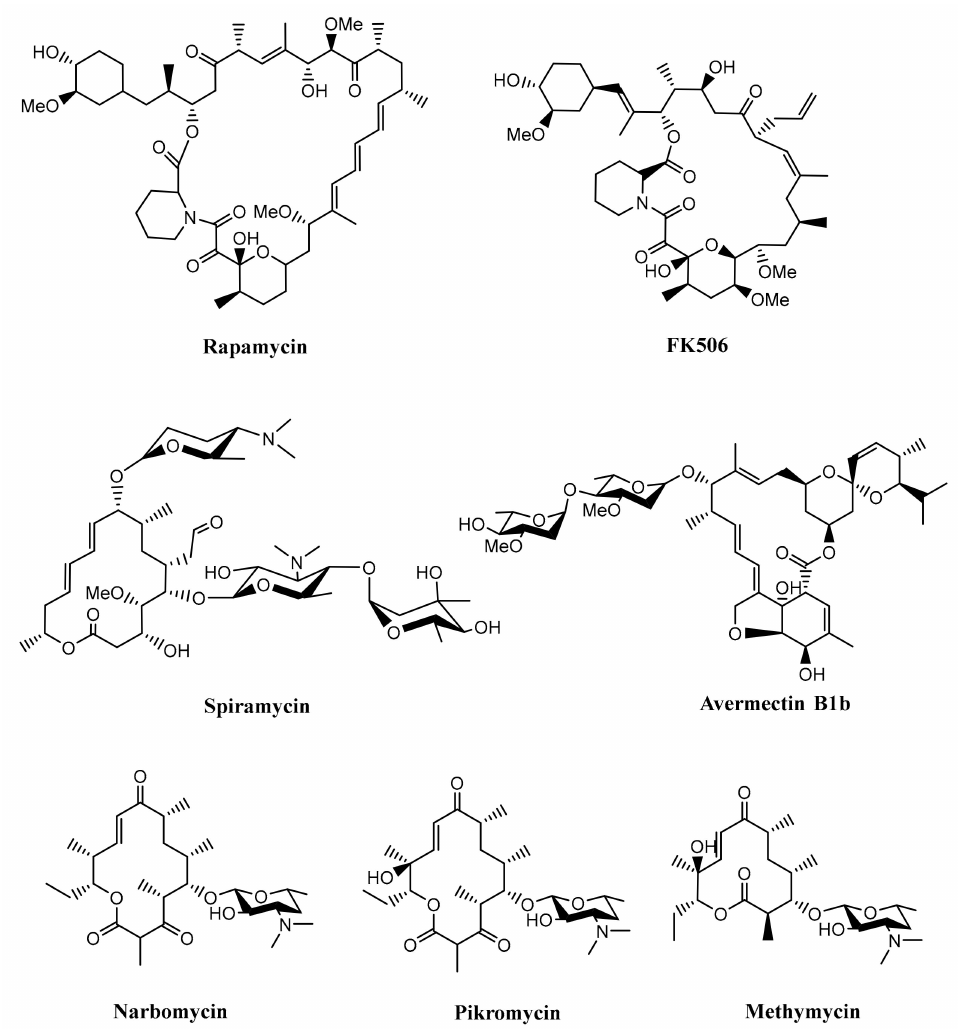
Figure 3. Some of the macrolides produced by Streptomyces